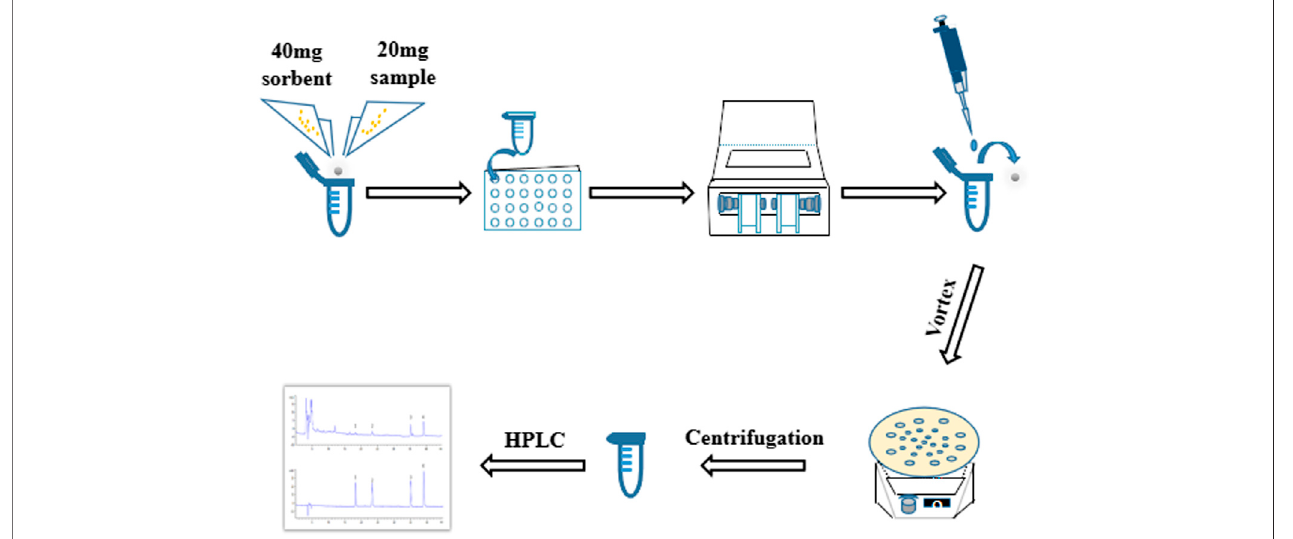
FIGURE 1 | Schematic diagram of vibration and vortex-assisted MSPD